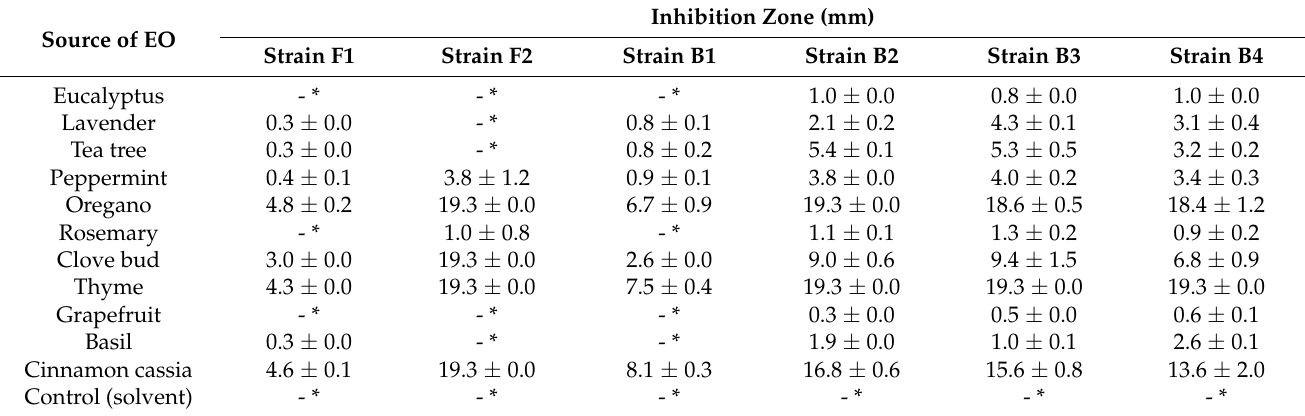
Table 2. Effect of tested essential oils (pure) on microbial strains isolated from Buyeo Royal Tomb No. 1.